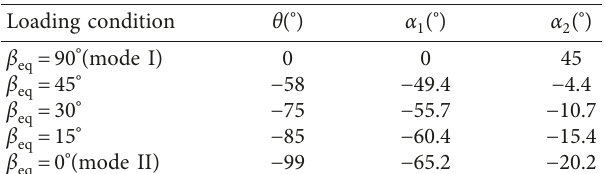
Figure 6: The distribution of stress triaxiality at the crack tip in the loading conditions of (a) mode I ( β Table 3: The position of maximal triaxiality at crack tip and the maximal principal stress and the maximal shear stress at the po- sition where the maximal stress triaxiality is located in the loading conditions from mode I to mode